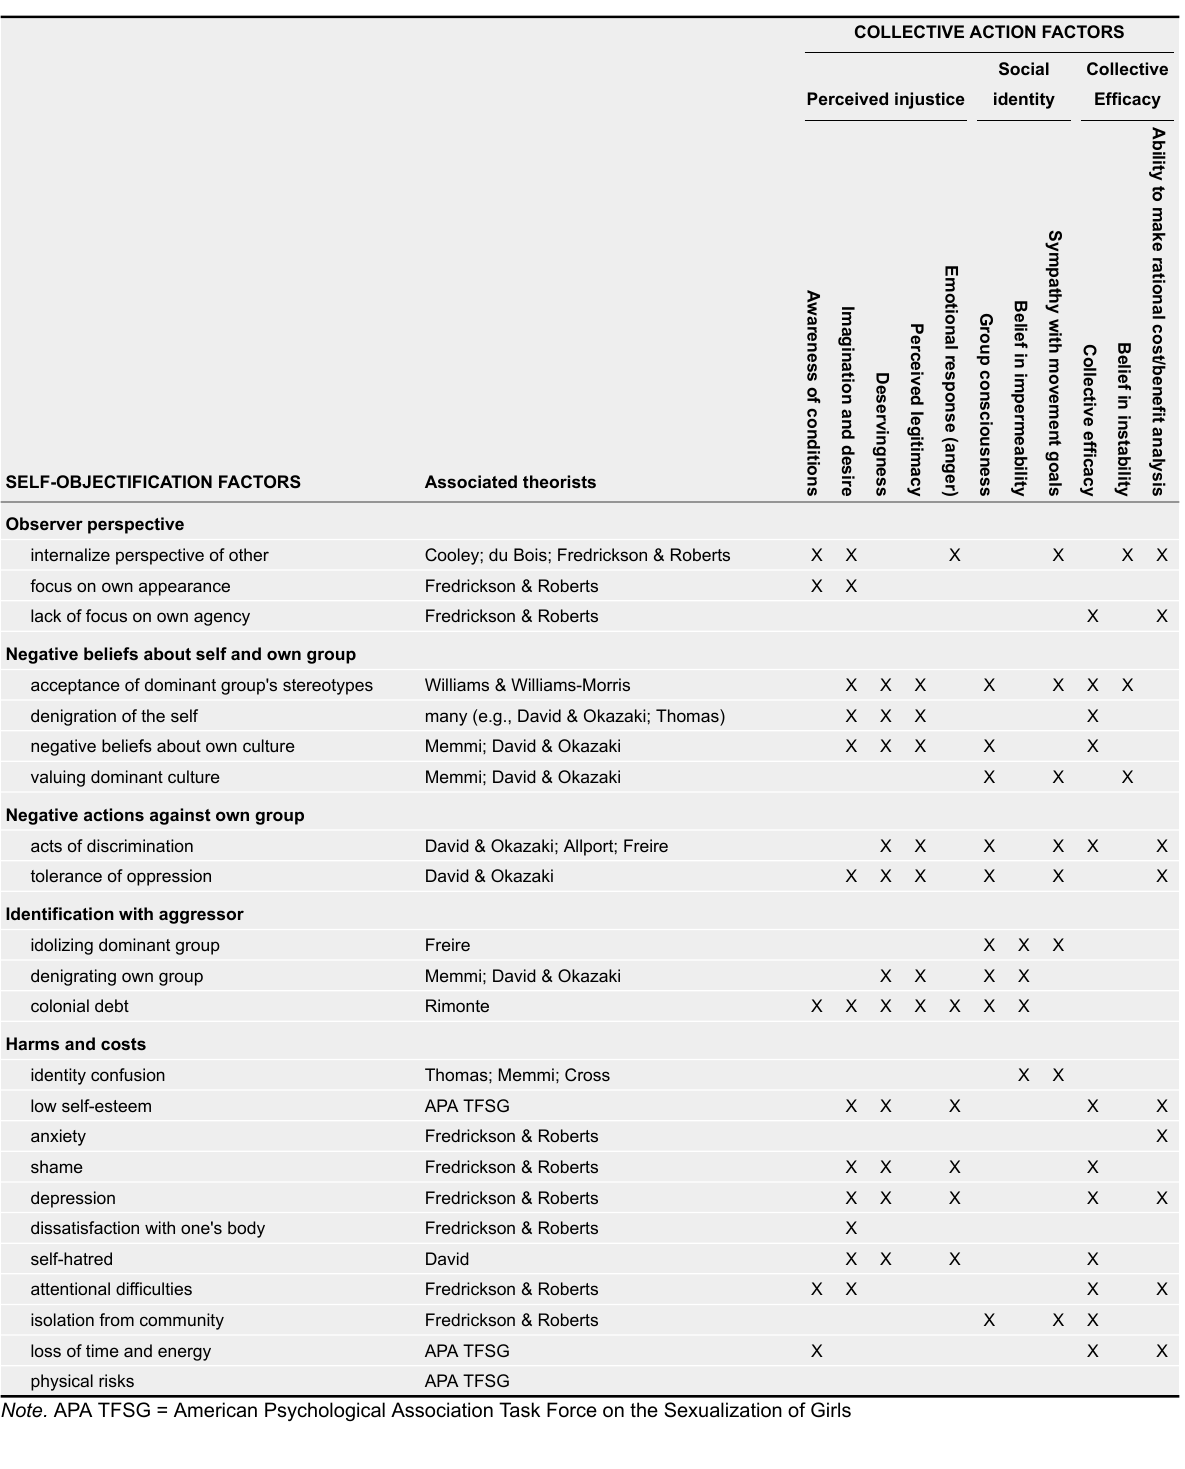
Connections between Self-Objectification and Collective Action